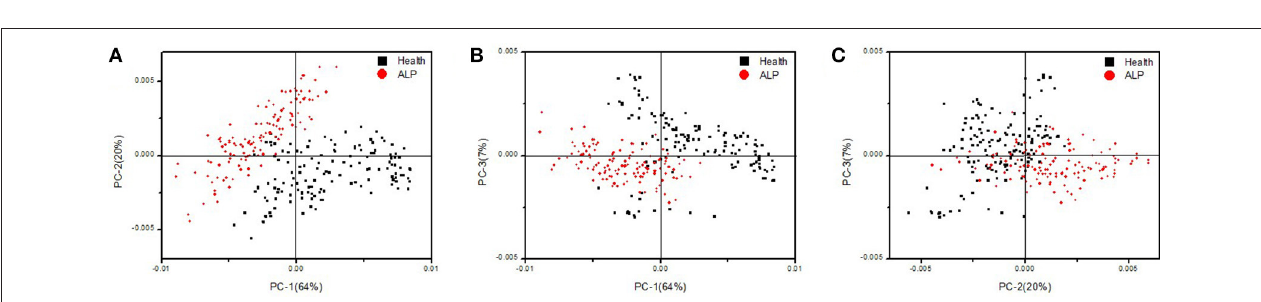
FIGURE 3 | Two-dimensional score plots of PC-1 vs. PC-2 (A) , PC-1 vs. PC-3 (B) , and PC-2 vs. PC-3 (C) obtained after PCA applied to the FTIR second derivative spectra of the rat groups without and with ALP.